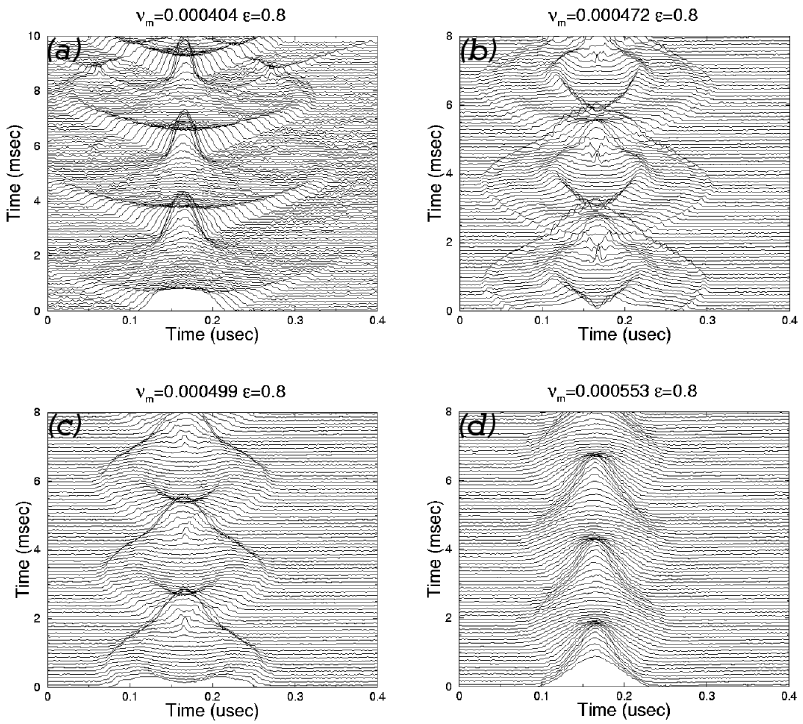
FIG. 5. Measurements of driven bunch shape oscillations for different modulation frequencies, as seen on a wall current monitor.